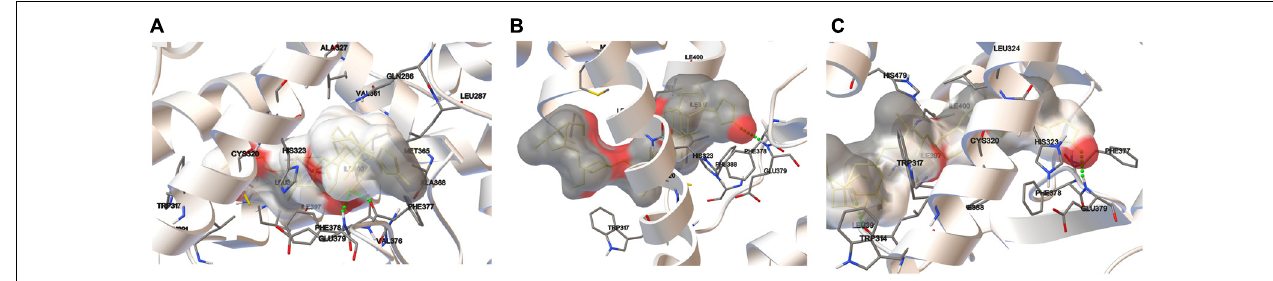
FIGURE 8 | Docking results for digoxin using the crystal structures of the ROR γ LBD: 3L0J (A) , 3B0W A (B) , and 3B0W B (C) . Amino acid residues are shown where relatively close ligand-receptor contact occurs. The ligand is surrounded by the electrostatic potential surface (based on the point charges). Hydrogen bonds are represented as green dotted